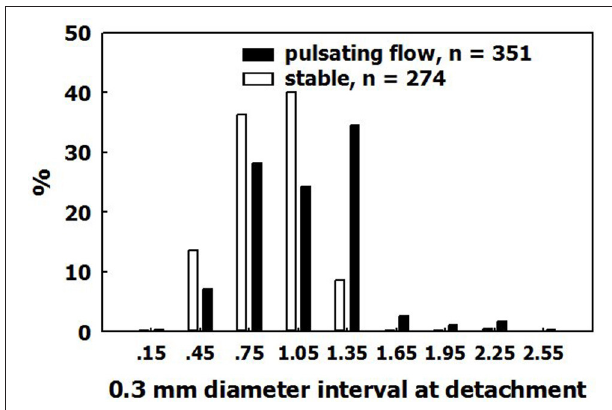
FIGURE 8 | Size on detachment. The distribution of bubble diameters on detachment, in pulsatile flow and in stable conditions.